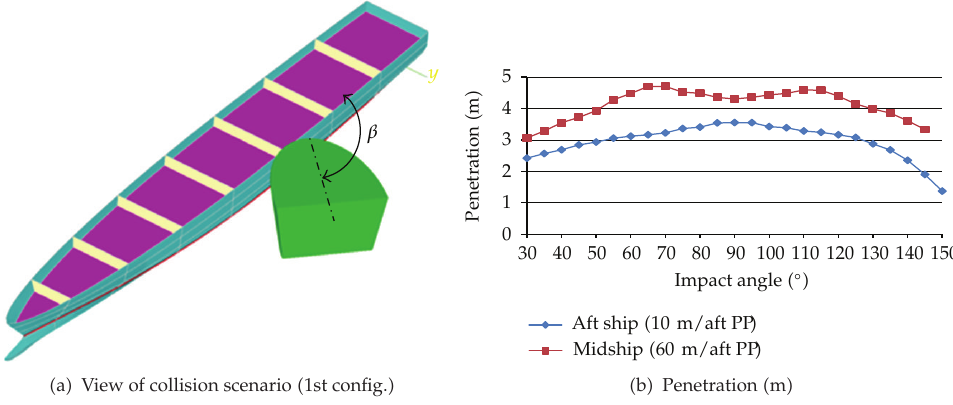
Figure 20: Sensitivity of damage penetration to impact angle.